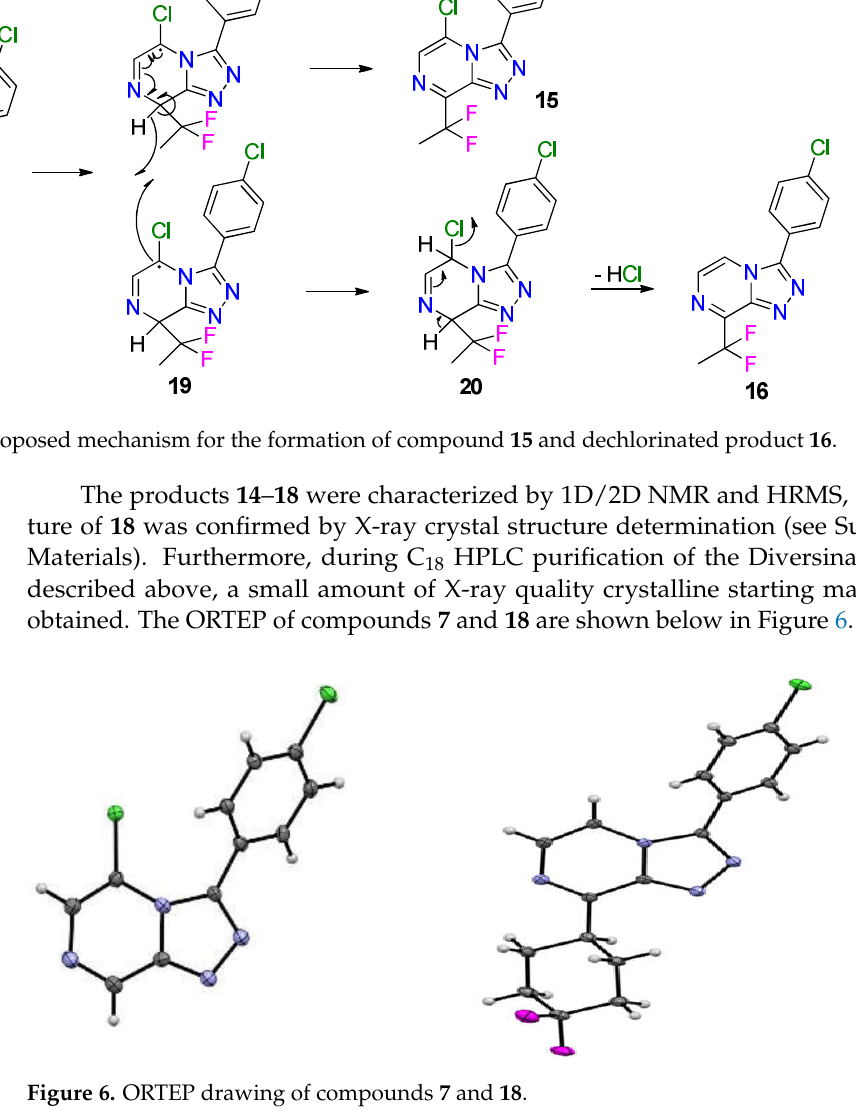
Figure 6. ORTEP drawing of compounds 7 and 18 .